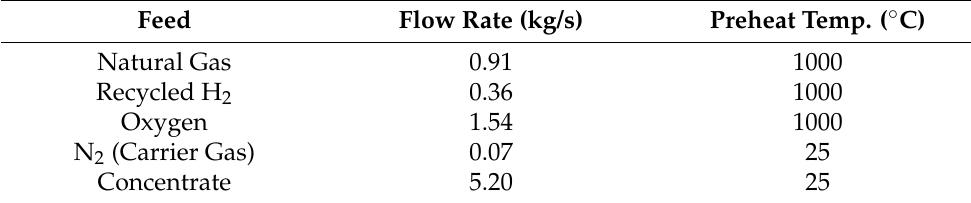
Table 7. Operating conditions for molten product with input gases preheated to 1000 ◦